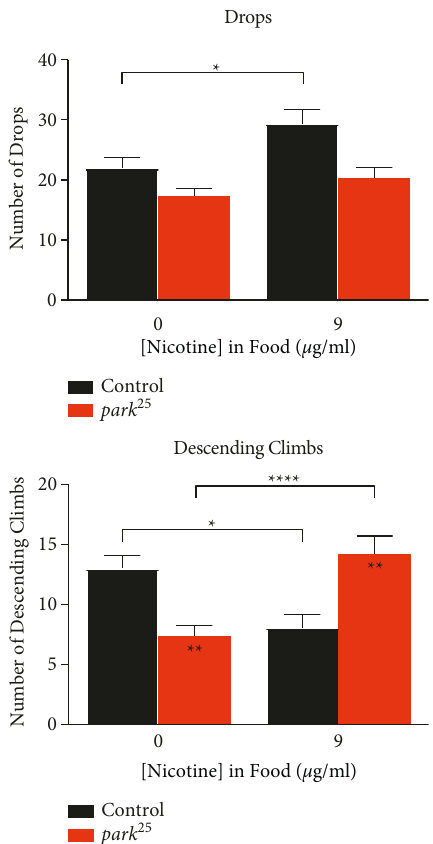
Figure 6: Nicotine treatment increases the number descending climbs in homozygous park 25 flies. Number of (a) drops or (b) descending climbs (see Methods for details) in nicotine-treated flies. Data are presented as mean and SEM. Results from a post hoc Tukey HSD analysis are shown. Asterisks inside the bars compare between the two genotypes at individual nicotine levels. ∗∗∗∗ � P < 0 . 0001, ∗∗ � P < 0 . 01 ∗ � P < 0 . 05. The results of each data point are from at least four separate experiments with an n ≥ 56